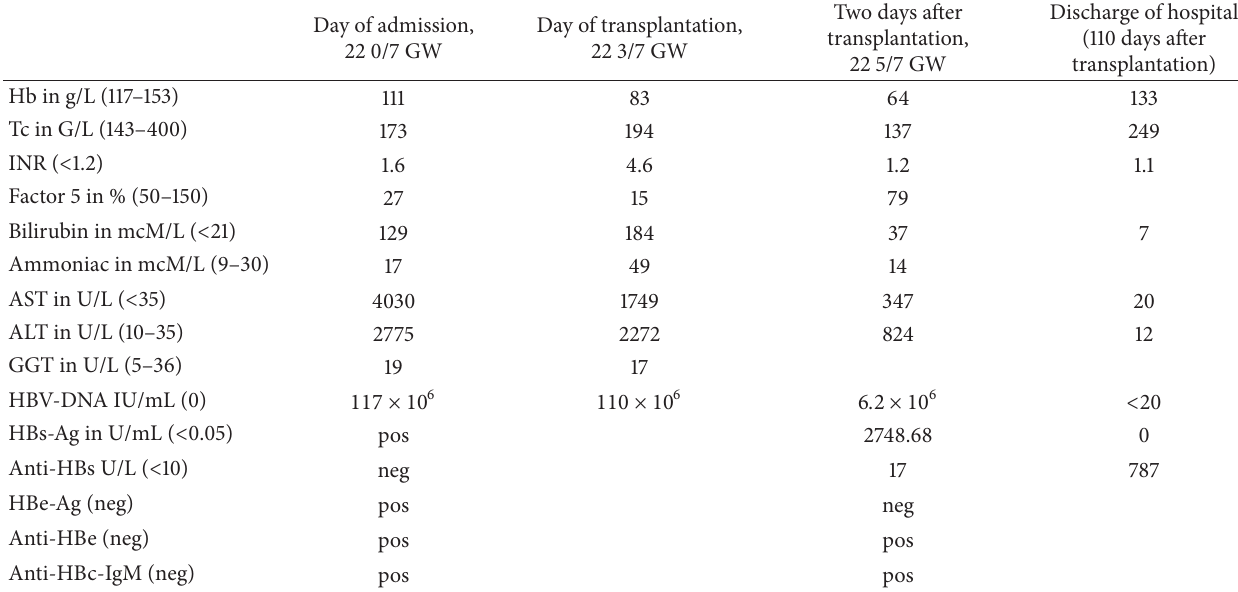
Table 1: Maternal laboratory values.